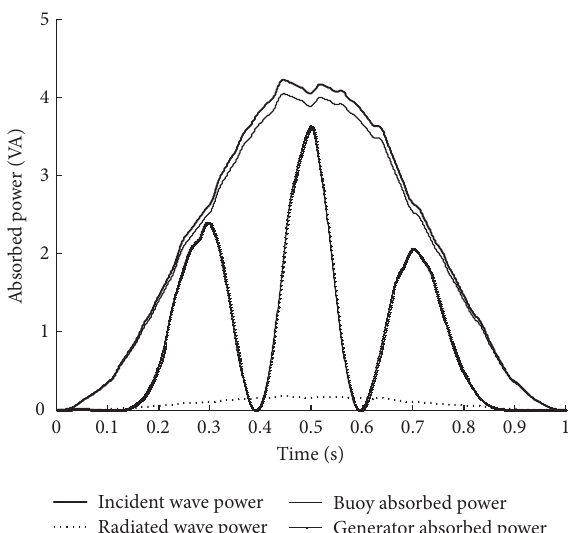
Figure 6: The heaving buoy absorbed power, incident wave power, radiated wave power, and active power of linear generator for one buoy